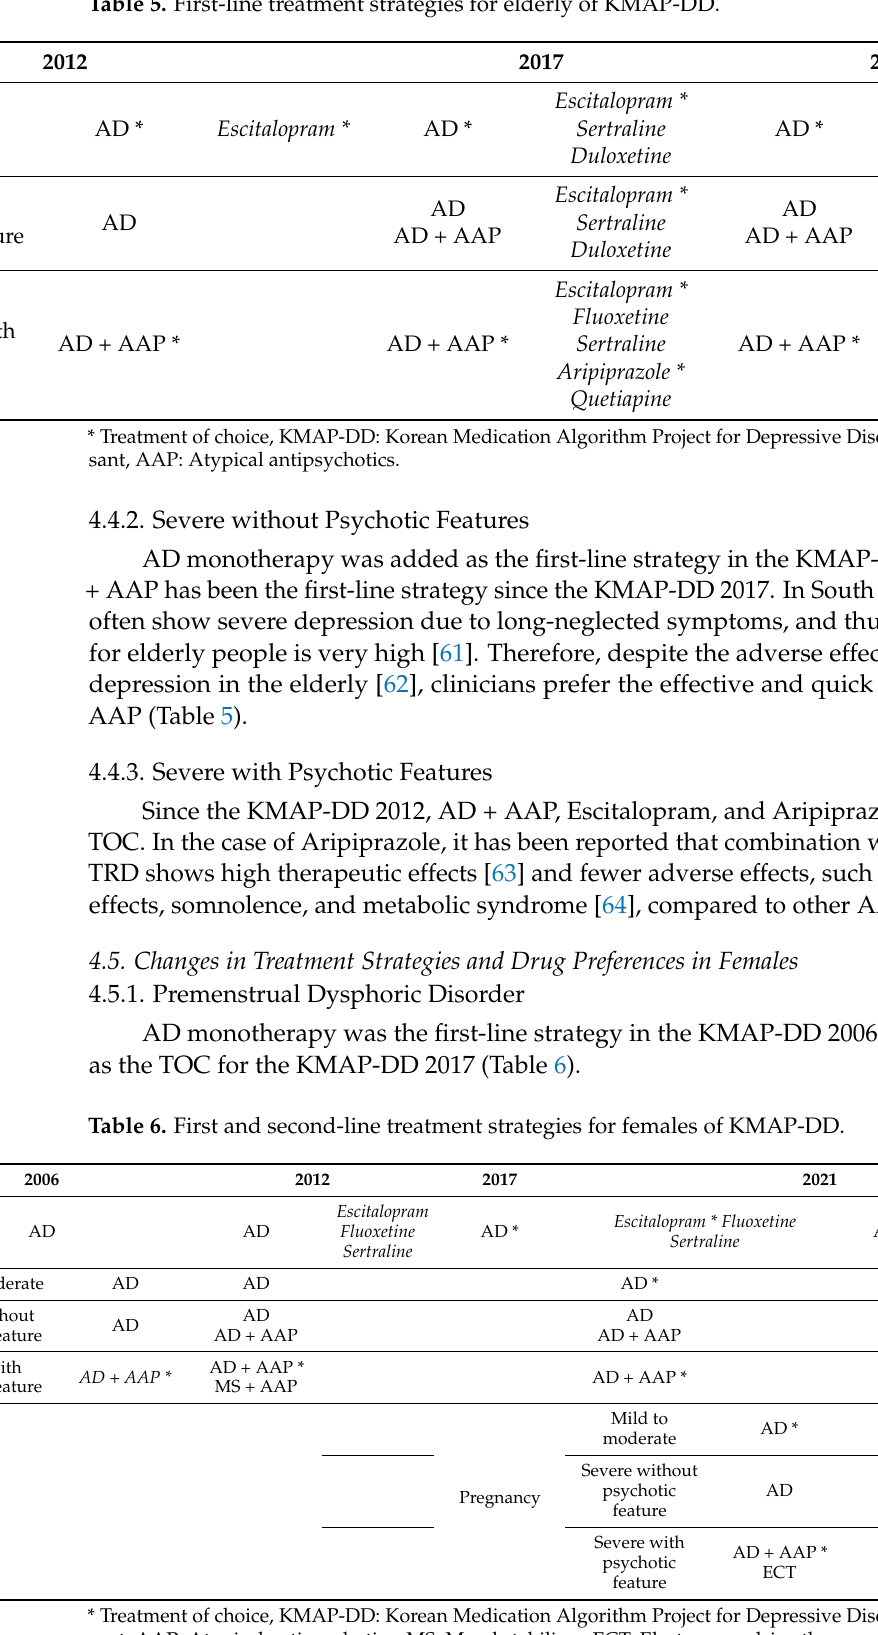
Table 5. First-line treatment strategies for elderly of KMAP-DD.